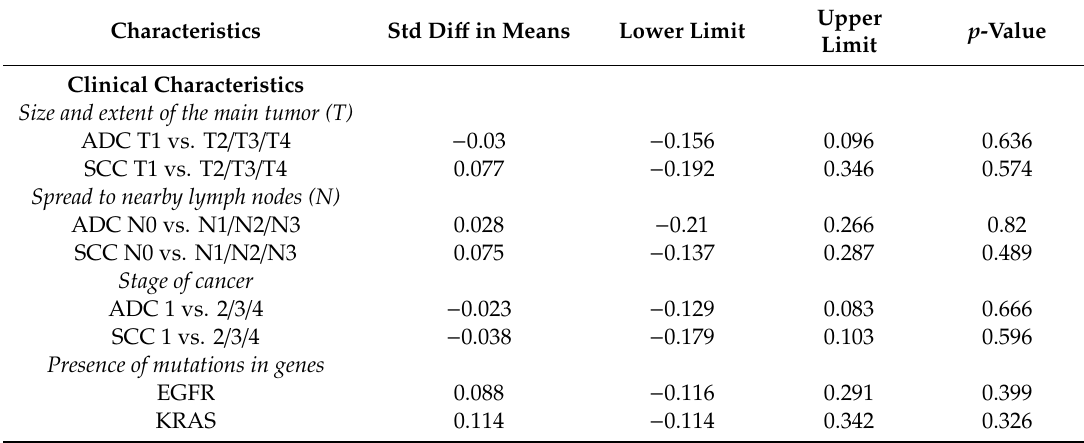
Table 2. Analysis of the association between SETDB1 mRNA expression and clinical and pathological characteristics.